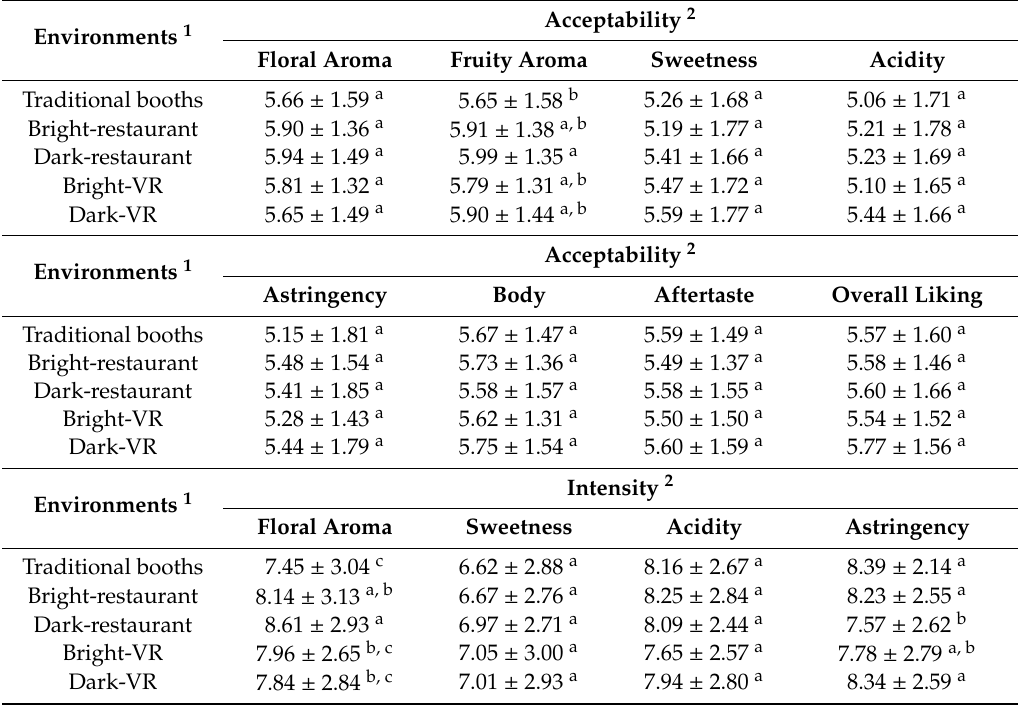
Table 2. Acceptability and intensity mean values of the wine sample in each environment 1